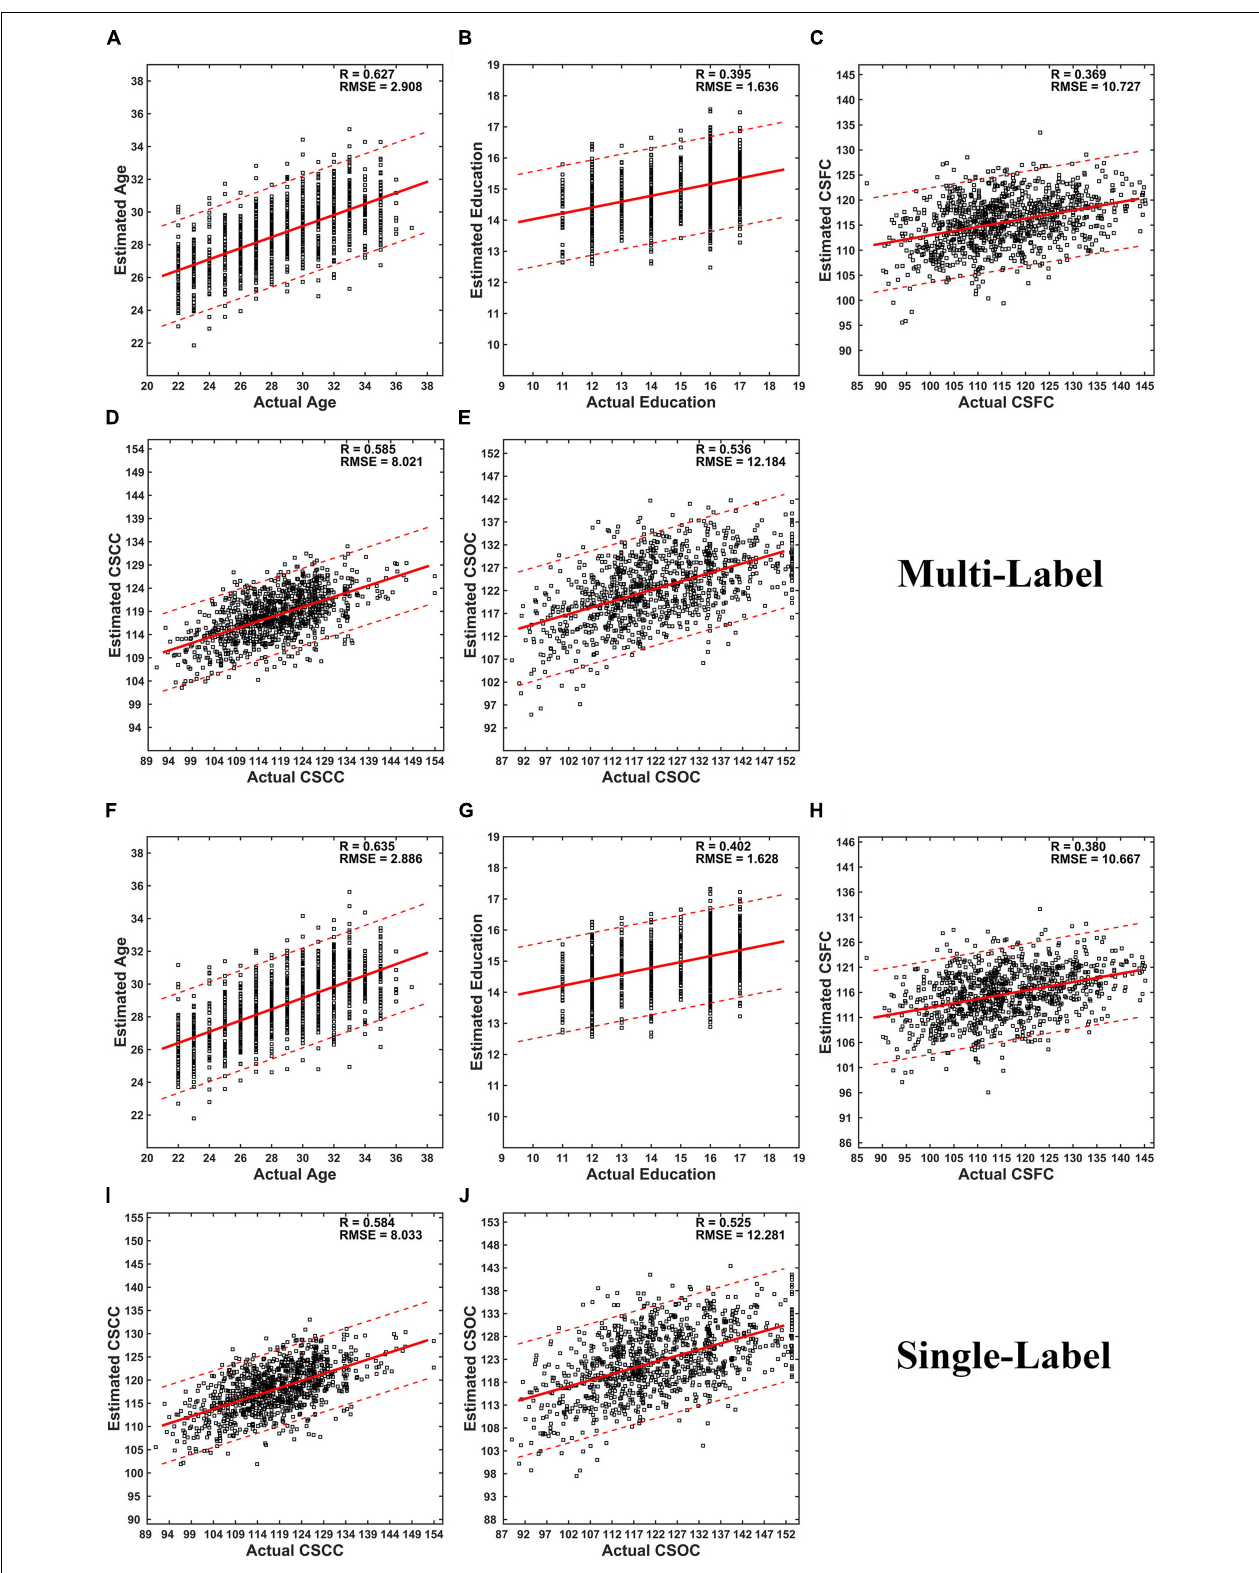
FIGURE 2 | Scatter plots of estimated vs. actual labels. (A–E) were based on the first set of estimations (multi-label learning), and (F–J) were based on the fourth set of estimations (single label learning). (A,F) Age; (B,G) Education; (C,H) CSFC; (D,I) CSCC; (E,J) CSOC.